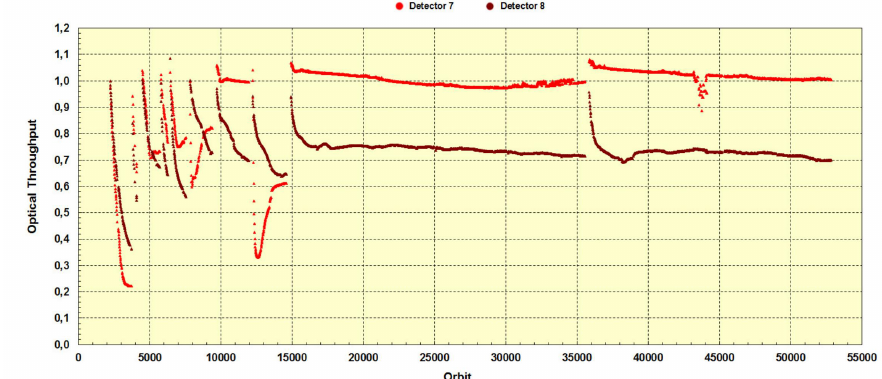
Figure 18. Degradation of SCIAMACHY throughput relative to August 2002 in Channel 7 & 8 in the calibration light path as a function of orbit